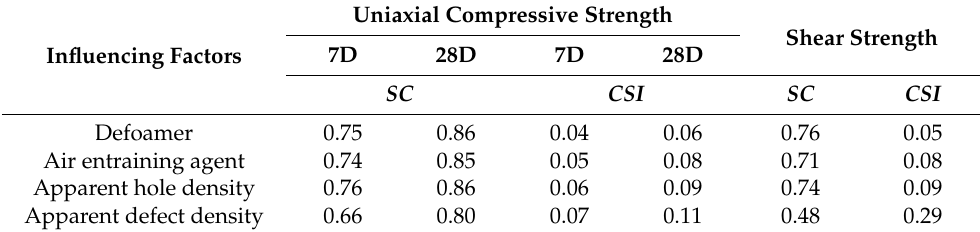
Table 8. SC and CSI of the influencing factors of SCFFC strength.